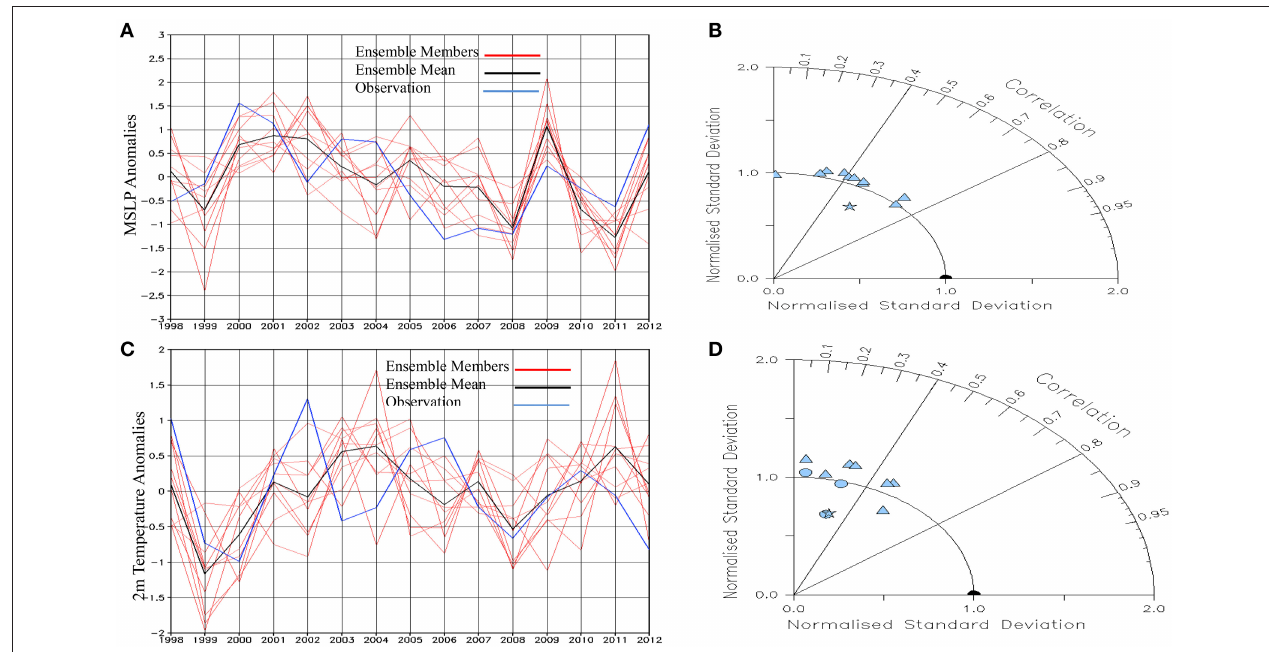
FIGURE 5 | Inter-annual variability of standardized anomalies of (A) MSLP and (B) 2m temperature anomaly averaged over Longitude 10 ◦ W − 15 ◦ E and Latitude 18–25 ◦ N area depicted as Heat-Low position by the ensemble members (red-lines), the ensemble mean (black-line) and observed Era-Interim (blue-line); (B,D) . Taylor diagrams showing the normalized standard deviations and the correlation coefficients of S2S ensemble simulations with observation for (A,C) respectively (ensemble members—blue triangle; blue circle for negative correlations), ensemble mean—blue star and Era-Interim (observation)—black semi-circle. The normalized standard deviations and correlations are with reference to Era-Interim over same